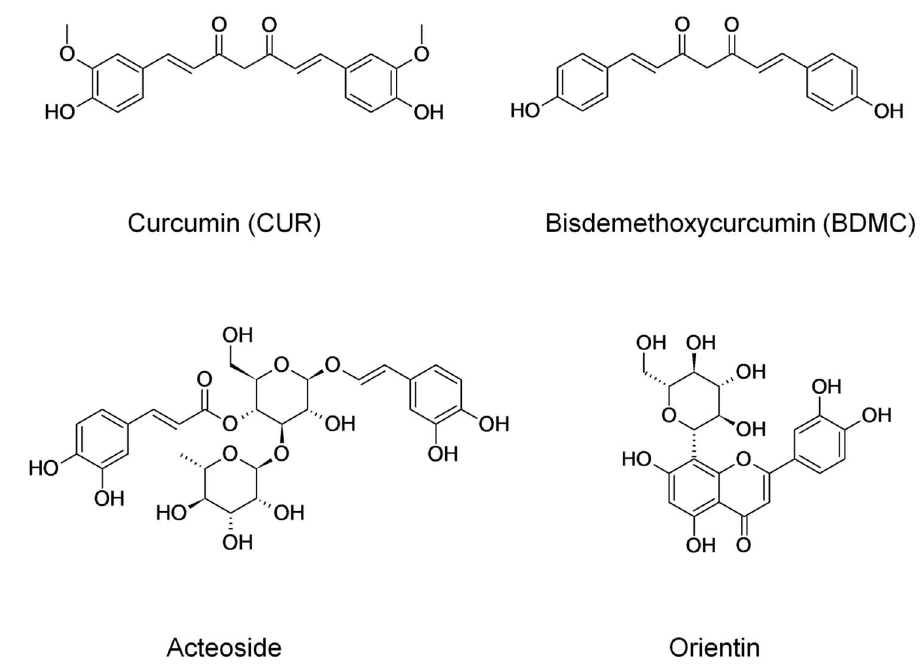
Figure 1. Chemical structures of natural products used in this study: curcumin (CUR); bisdemethoxycurcumin (BDMC); Acteoside, and Orientin.